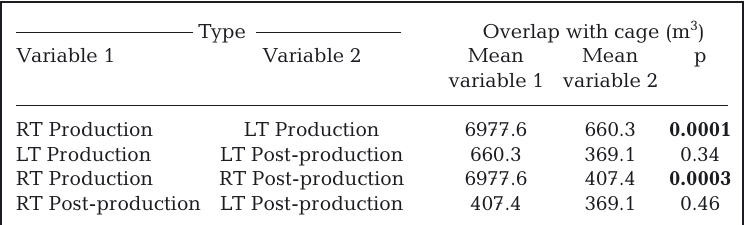
Table 2. Comparison of rainbow trout Oncorhynchus mykiss (RT) and lake trout Salvelinus namaycush (LT) volumetric overlap with the cage site (near cage habitat; for details, see Materials and Methods) during years of aqua - culture production (2006−2007) and the post-production period (2007−2008). P-values presented are a result of the randomization test; values in bold are significant at p <